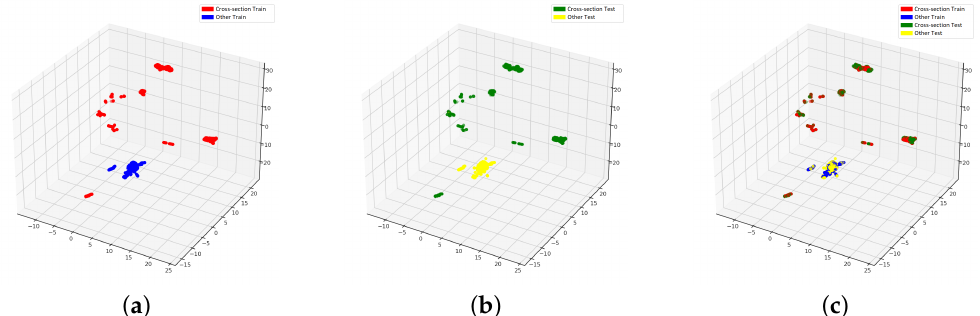
Figure 4. UMAP embedding space of DenseNet201 on training and test set. ( a ) shows cross-section and other labeled data from the training set, ( b ) shows cross-section and other labeled data from test set, ( c ) illustrates both labeled train and test data points in the same representation